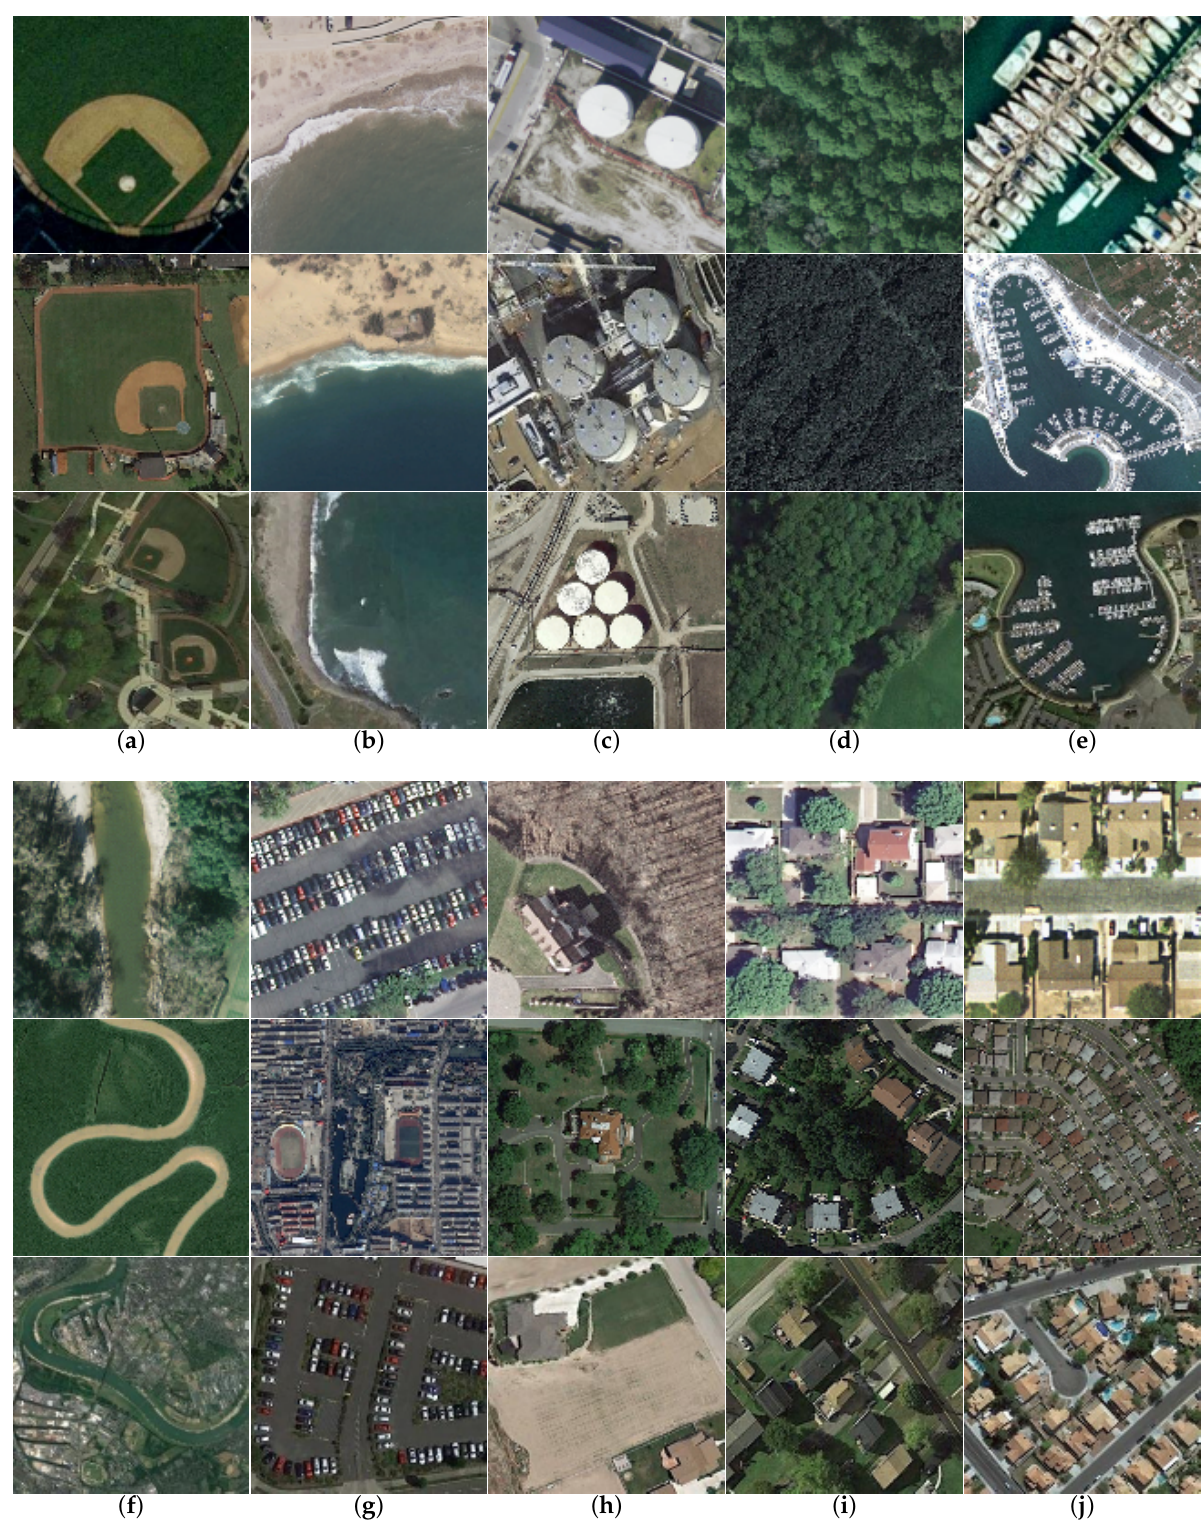
Figure 6. Illustrations of images of three optical high-resolution remote sensing image scene classifi- cation datasets. UC Merced, AID, and NWPU-RESISC45 datasets are displayed sequentially from top to bottom: ( a ) Baseball court; ( b ) Beach; ( c ) Storage tank; ( d ) Forest; ( e ) Harbor; ( f ) River; ( g ) Parking; ( h ) Sparse residual; ( i ) Medium residual; and ( j ) Dense